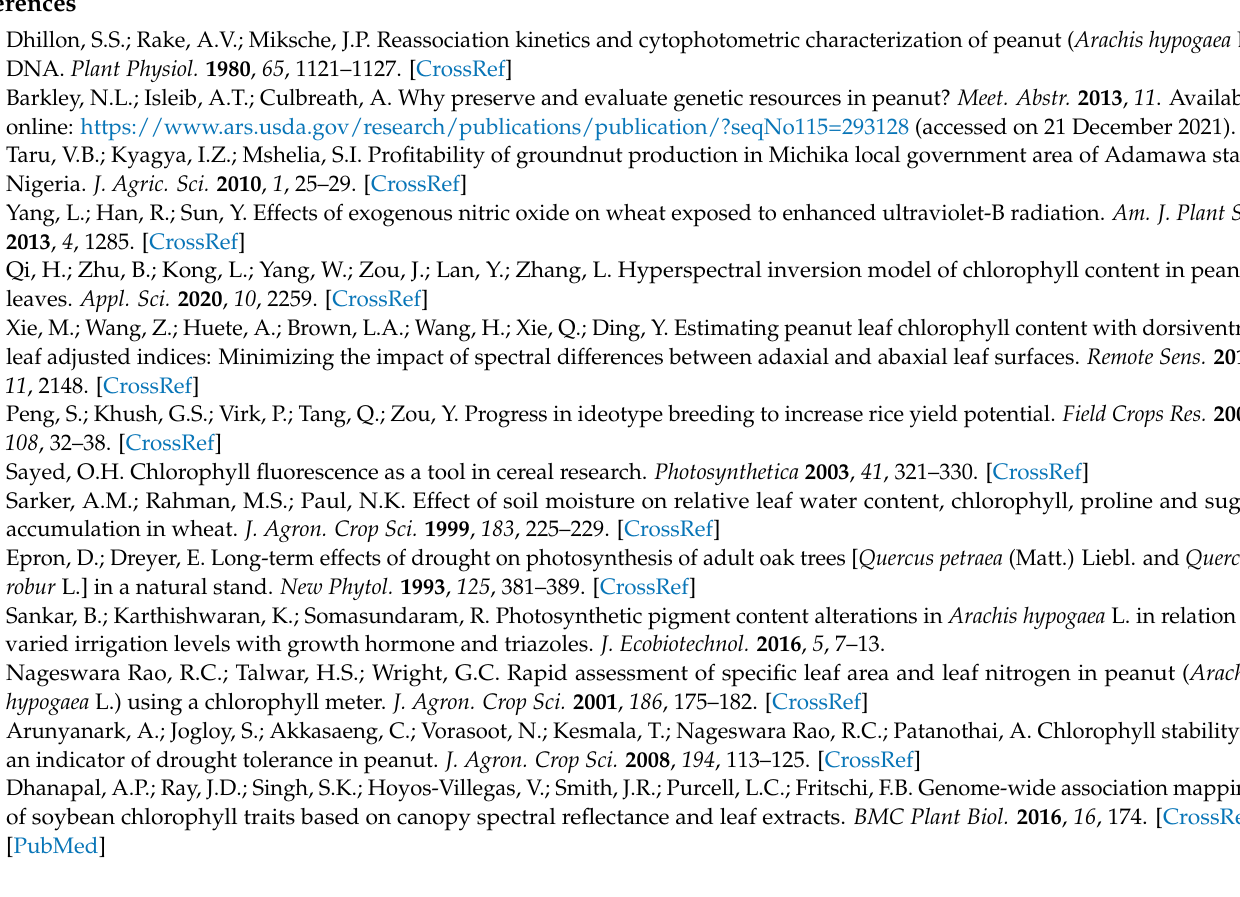
Supplementary Materials: The following are available online at https://www.mdpi.com/article/ 10.3390/agronomy12010152/s1; Figure S1a: Cross-validation error with K value; Figure S1b: ADMIX- TURE subpopulations structure analysis of the genotype data from 453 peanuts; Figure S2: A study design flow chart; Table S1: Information on the 453 peanut accessions; Table S2: The leaf chlorophyll content of the 453 peanut accessions; Table S3: A high-density SNP array using Axiom_Arachis with 58 K SNPs; Table S4: Information on the peanut genome from the 58K SNP array chip; Table S5: The evaluation of the genotype frequencies of SNP AX-176820297 with 20 peanut accessions; Table S6: The evaluation of the genotype frequencies of SNP AX-176820297 with 392 peanut accessions; Table S7: Pairwise LD measurements on chromosome Araip.B05; Table S8: A list of genes in the significant region, with annotations, identified by the Arachis hypogaea Tifrunner 1.0 reference; Table S9: The expression level and correlation of the Arahy. SDG4EV and Arahy.X7LG4K